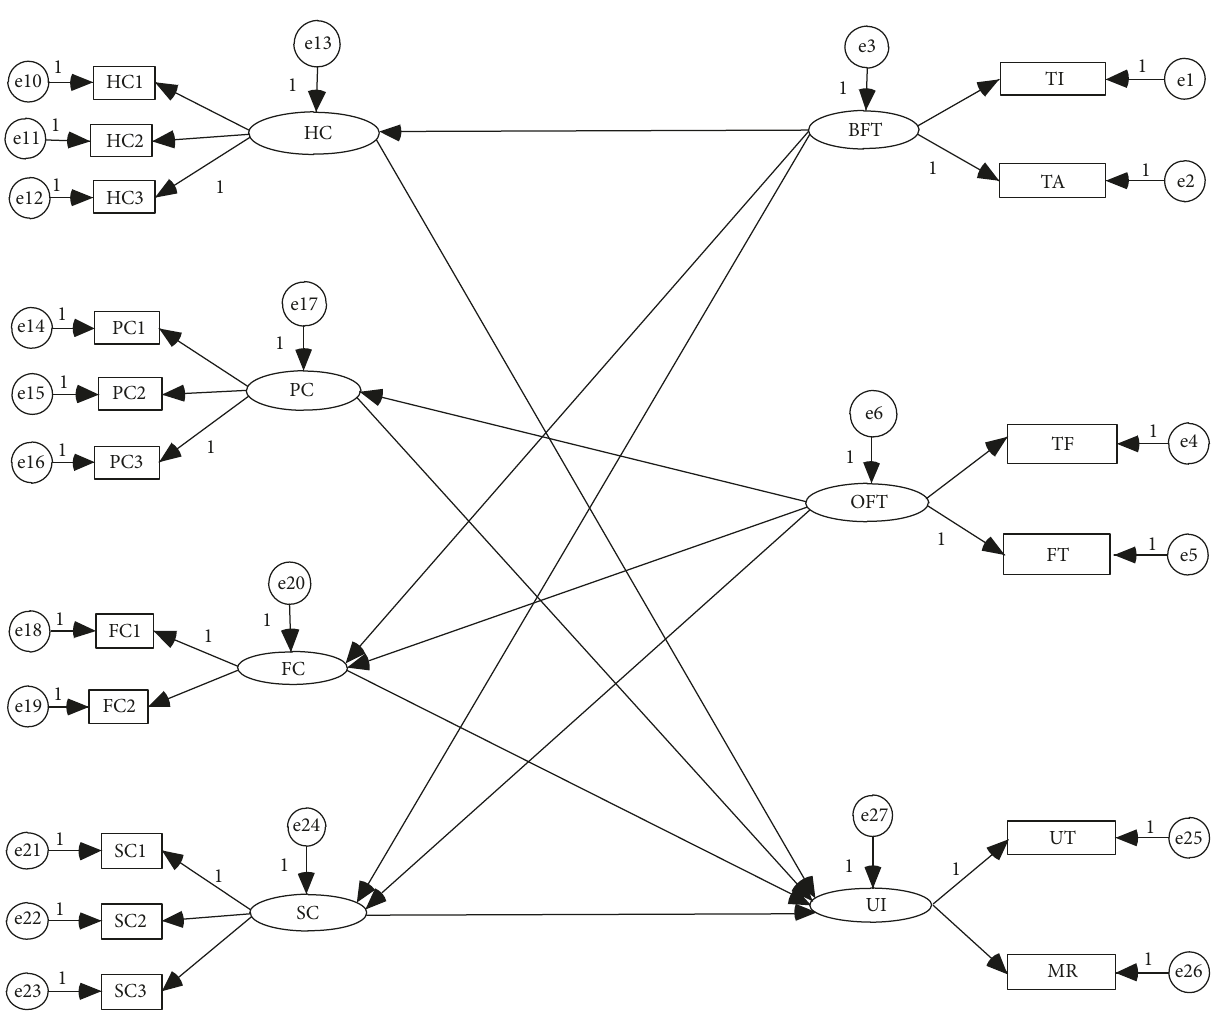
Figure 3: Final structural equation model . Abbreviations: BFT, Benefit of farmland transfer; OFT, Openness in farmland transfer; TI, Transfer income; TA, Transfer area; TF, Transferee; FT, Farmland transfer tenure; UI, Willingness to urbanism; UT, Urbanization type; MR, Migration region; NC, Natural capital; NC1, Farmland area; NC2, High quality farmland; HC, Human capital; HC1, Education level; HC2, Labour force; HC3, Health status; PC, Physical capital; PC1, Residential quantity; PC2, Residential quality; PC3, Public transportation; FC, Financialcapital; FC1, Nonagricultural income; FC2, Capacity to borrow; SC, Social capital; SC1, Relationship with friends; SC2, Relationship with relatives; SC3, Relationship with village